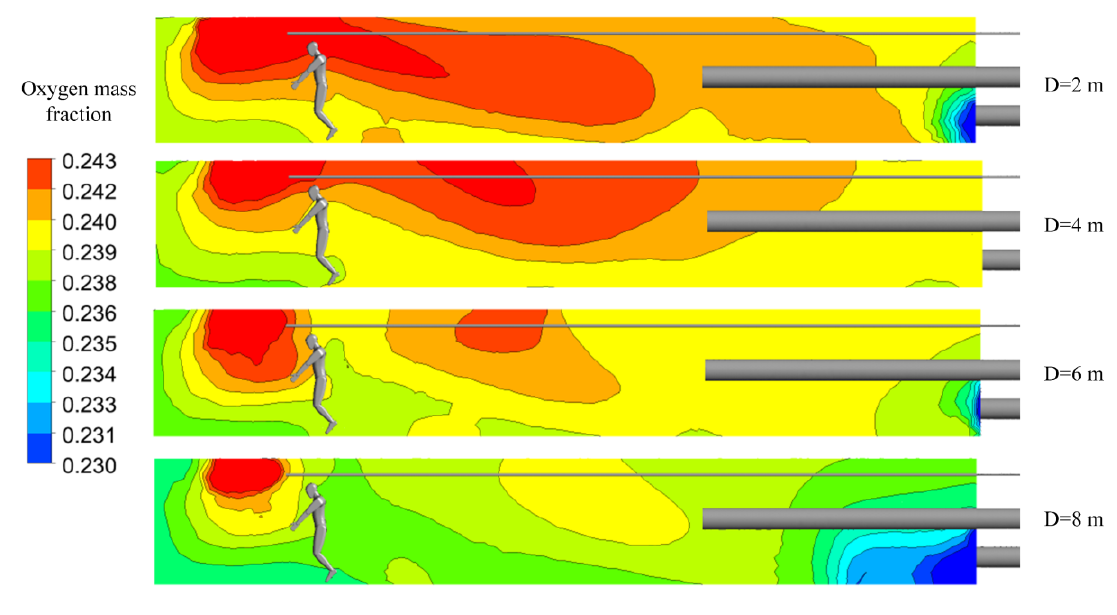
Figure 13. Distributions of oxygen mass fractions at section X = 0 m.